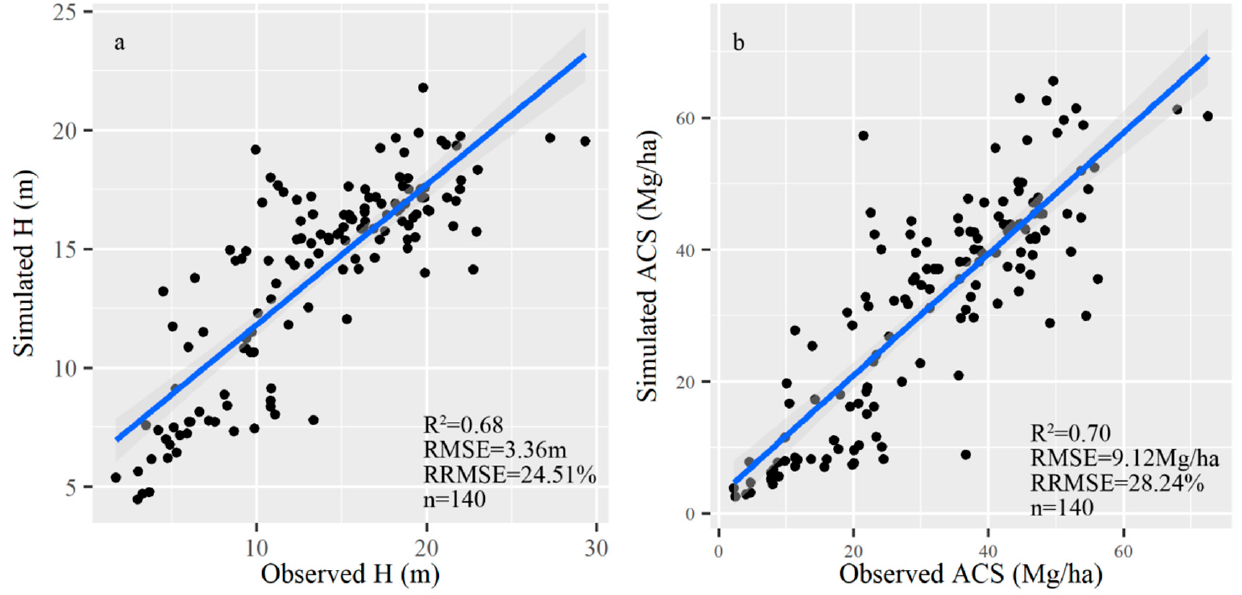
Figure 8. Validation of simulated height ( a ) and aboveground carbon stocks ( b ) based on forest age data from Landsat.